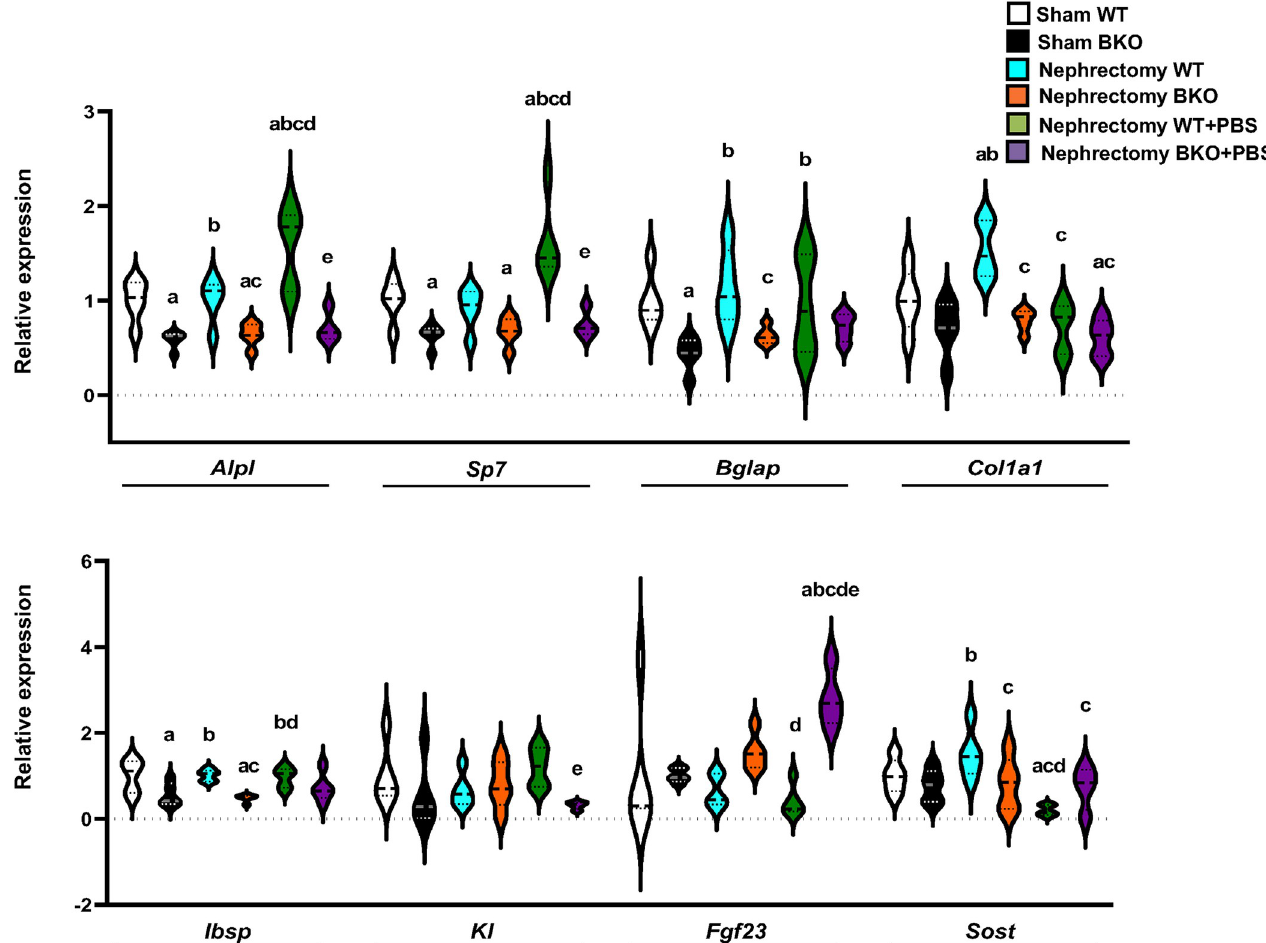
Fig 6. Nephrectomy of WT with or without PBS exposure upregulates osteoblast-related gene expression in femurs. Violin plots for qPCR analysis of osteoblast-related genes (n = 4–5 per group). a p < 0.05 versus sham WT, b p < 0.05 versus sham BKO, c p < 0.05 versus nephrectomized WT, d p < 0.05 versus nephrectomized BKO, and e p < 0.05 versus nephrectomized WT+PBS.